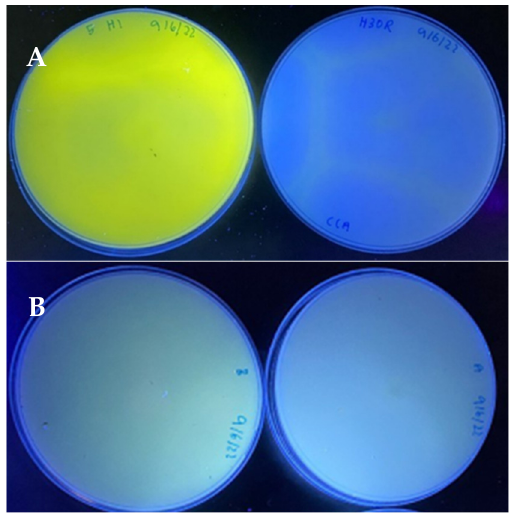
Figure 2. Green fluorescence (left side) was detected on the reverse colony of ( A ) A. flavus and ( B ) A. niger , which were able to produce AF and OTA on CCA, respectively, while no fluorescence was detected on the non-producer isolates (right side). The fluorescence was observed under UV light (365 nm) after 10 days of incubation.